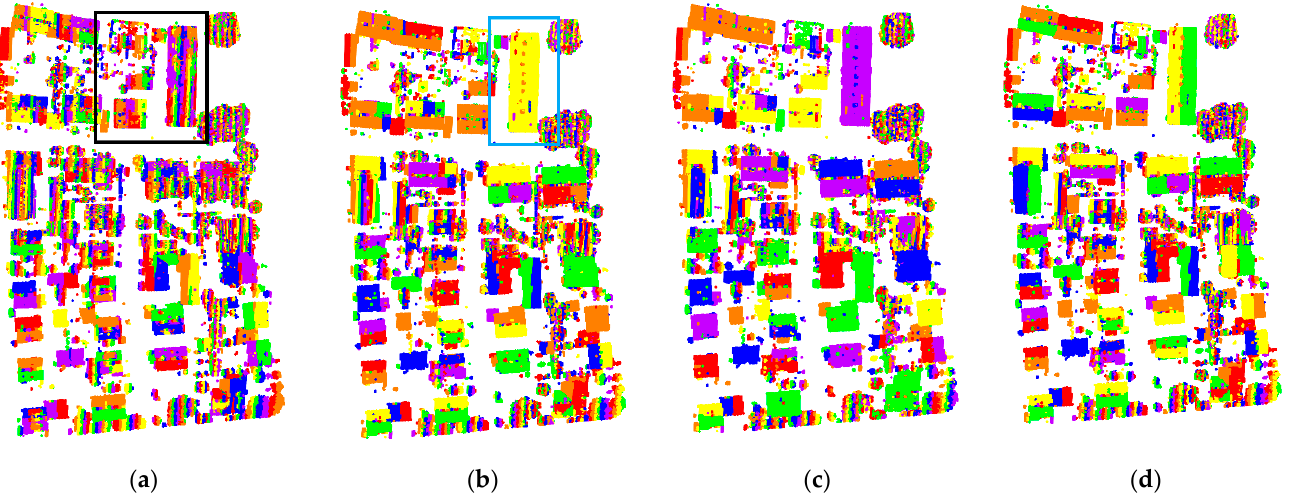
Figure 8. Graph segmentation results with different ς . ( a ) ς = 1 ◦ ; ( b ) ς = 10 ◦ ; ( c ) ς = 15 ◦ ; ( d ) the reference segmentation results. Different object primitives are colored with different colors.